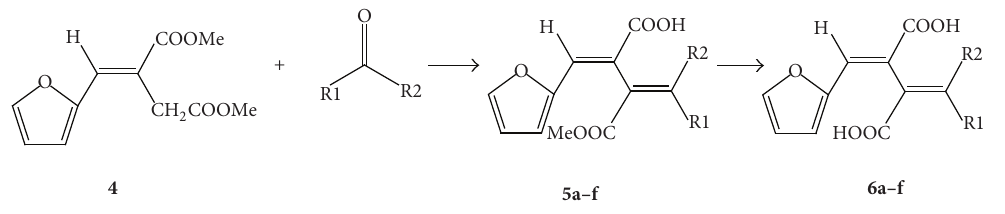
S 3: Synthesis of